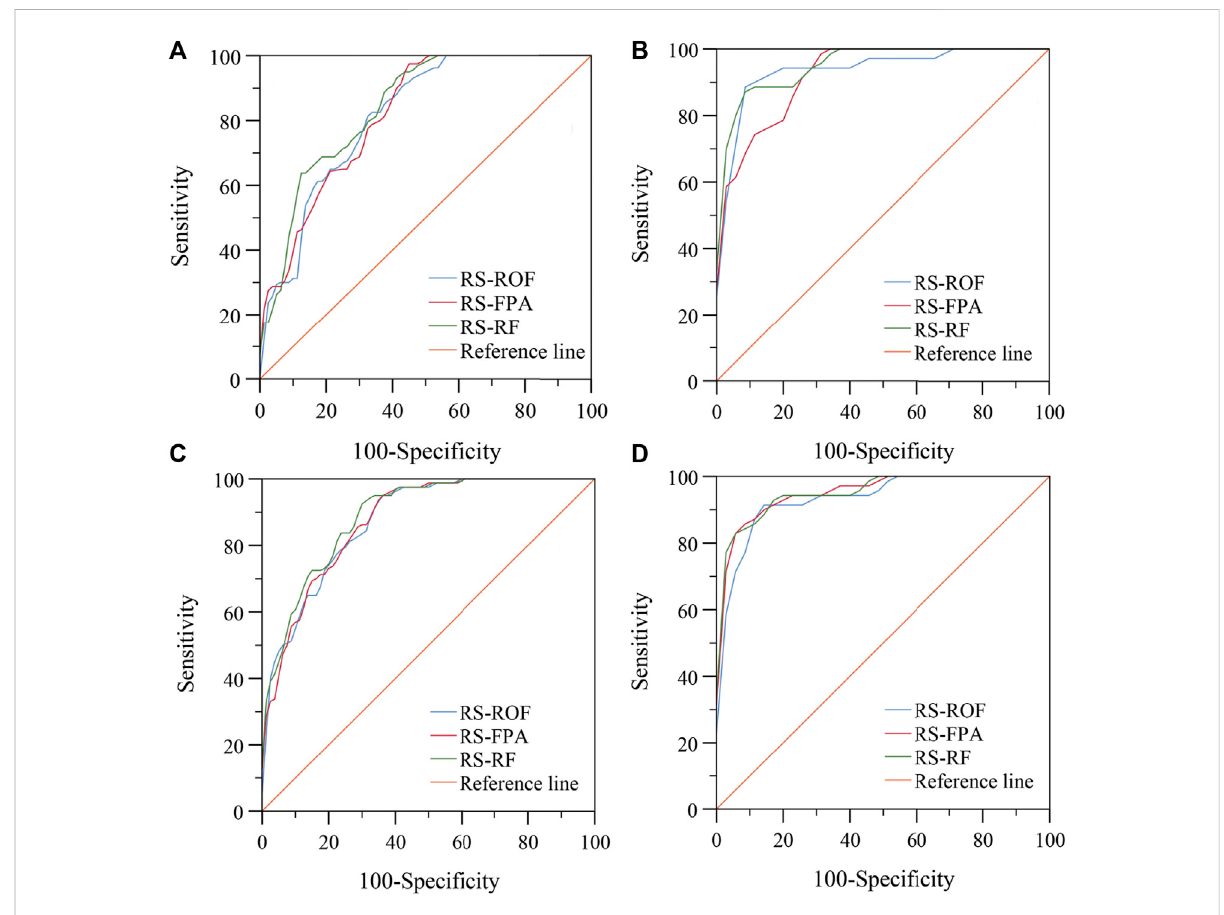
FIGURE 8 ROC curves of the models using: (A) training set of grid units; (B) validation set of grid units; (C) training set of slope units; (D) validation set of slope units.